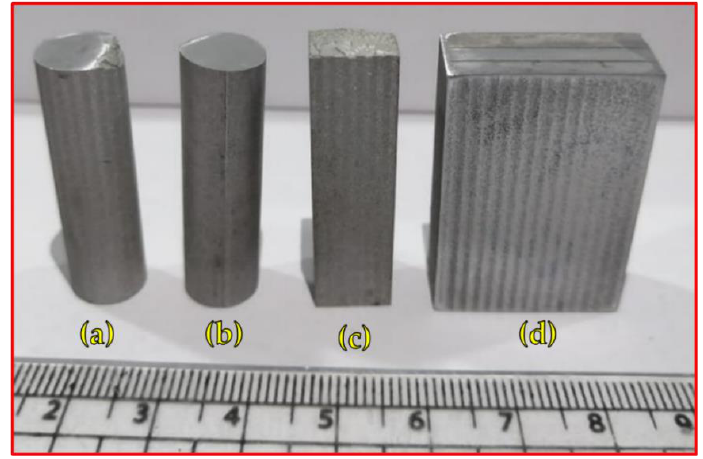
Figure 4. Image of the cut specimens from produced AMPs and AMCs for further investigation: ( a ) compression test sample; ( b ) wear test sample; ( c ) density measurement sample; ( d ) hardness and microstructure sample. Table 2. Dimensions and standards of the cut specimens for different tests.